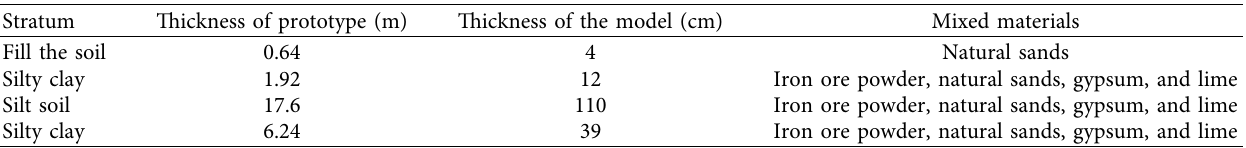
Table 5: Simulation materials of each stratigraphic.